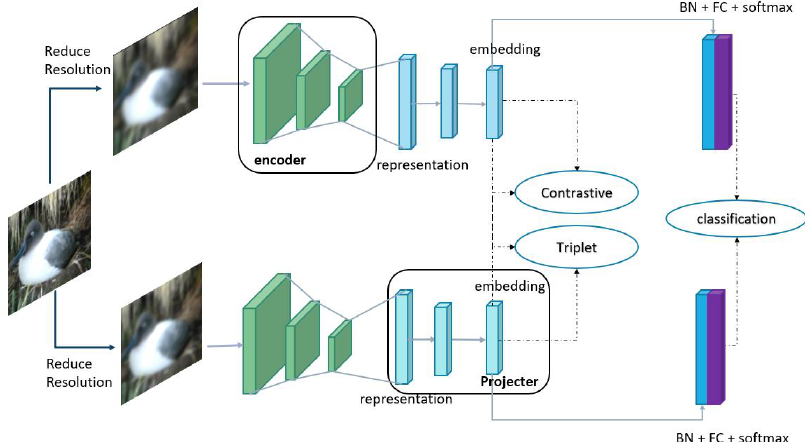
Figure 2. The overall architecture of our proposed framework. The framework is described using five major computing steps. (1) An input image is augmented into two views with different resolutions for contrastive learning. (2) Two augmented images go through a shared encoder module to extract representation vectors. (3) A projection head is added on top of the encoder model to perform non-linear mapping into an embedding space so that (4) contrastive and triplet loss can be established to maximize the similarity of positive pairs and dissimilarity of negative pairs. (5) We add a linear layer with softmax activation followed by batch normalization to calculate all samples’ class probability from two branches.